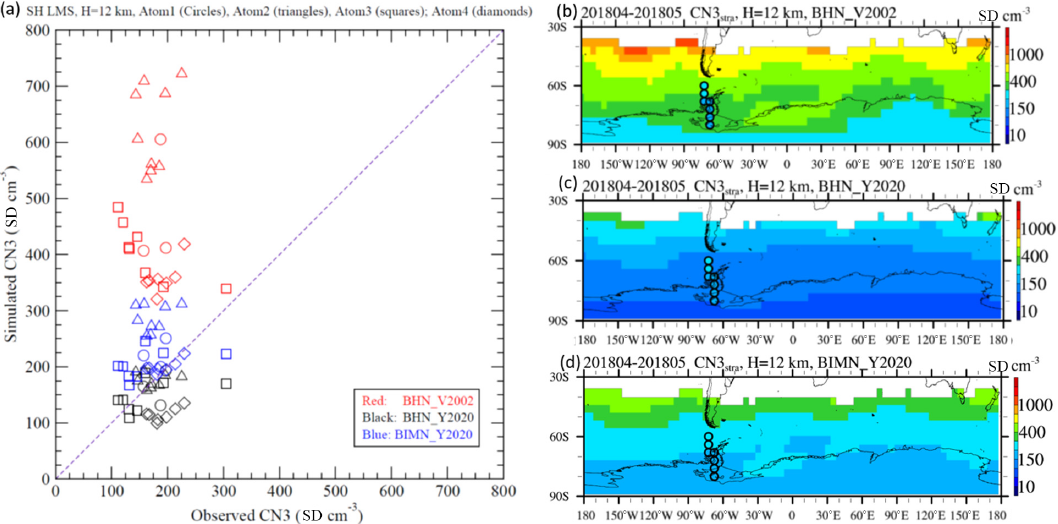
Figure 4. CN3 at altitudes of around 12km in the SH at middle and high latitudes: (a) model-simulated versus observed during ATom 1–4 (circles: ATom1, triangles: ATom2, squares: ATom3, diamonds: ATom4) and (b–d) model-simulated horizontal distributions corresponding to ATom 4 based on three different nucleation schemes (BHN_V2002, BHN_Y2020, and BIMN_Y2020), with the values and locations of ATom 4 CN3 measurements shown in the